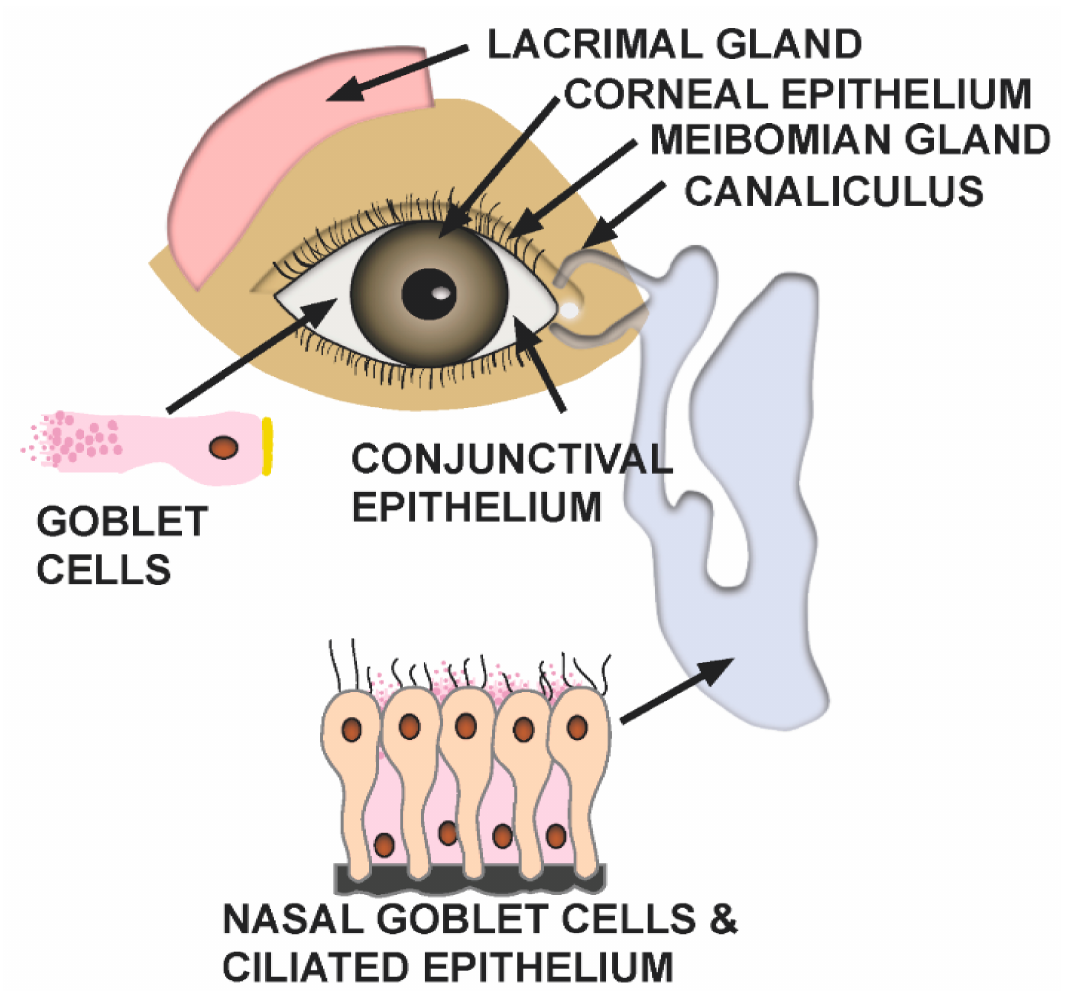
Figure 2. Structures at risk of infection from ocular exposure of SARS-CoV-2. Two potential pathways by which ocular exposure could lead to transmission of the SARS-CoV-2 virus include direct infection of ocular tissues as well as infection of nasal or gastrointestinal epithelium due to virus carried by tears through the nasolacrimal